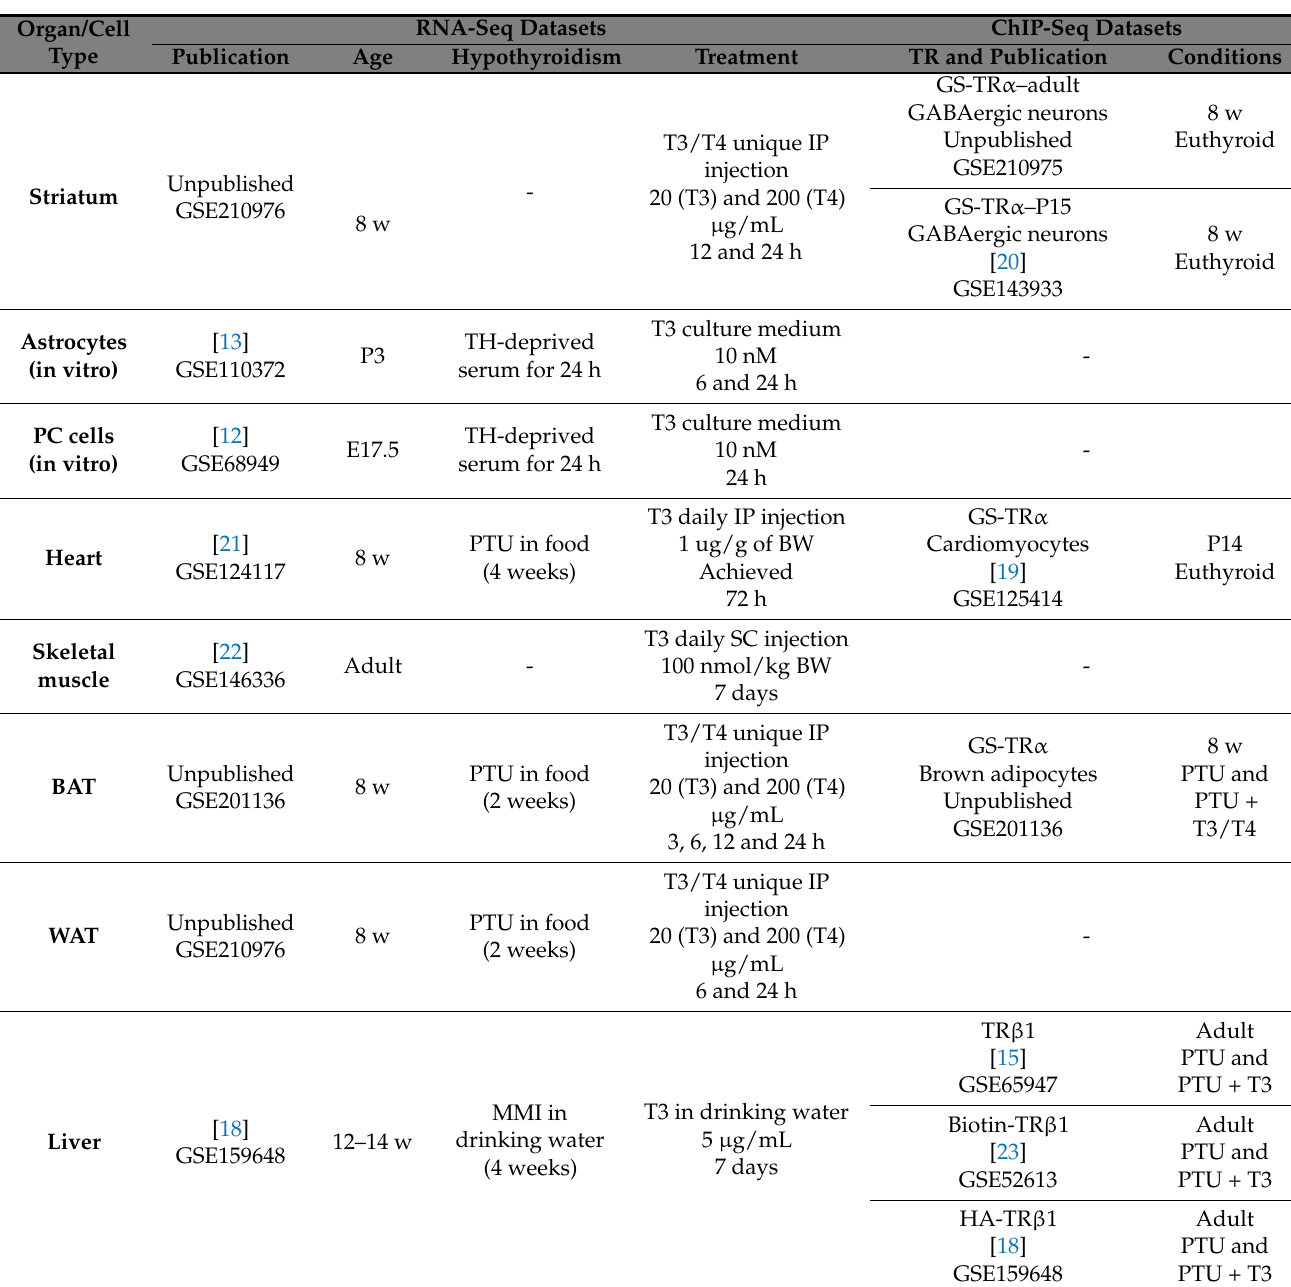
Table 1. Data included in the